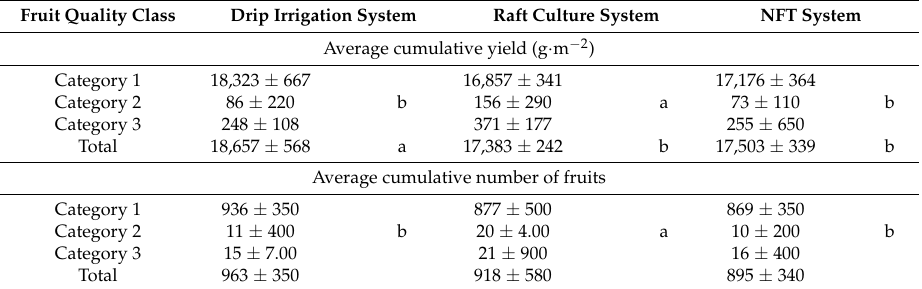
Table 3. Average cumulative and total yield (g · m − 2 ) and average number of tomato fruits ( ± SD) shown for three quality categories (Table 2) in drip irrigation system, raft culture system, and nutrient